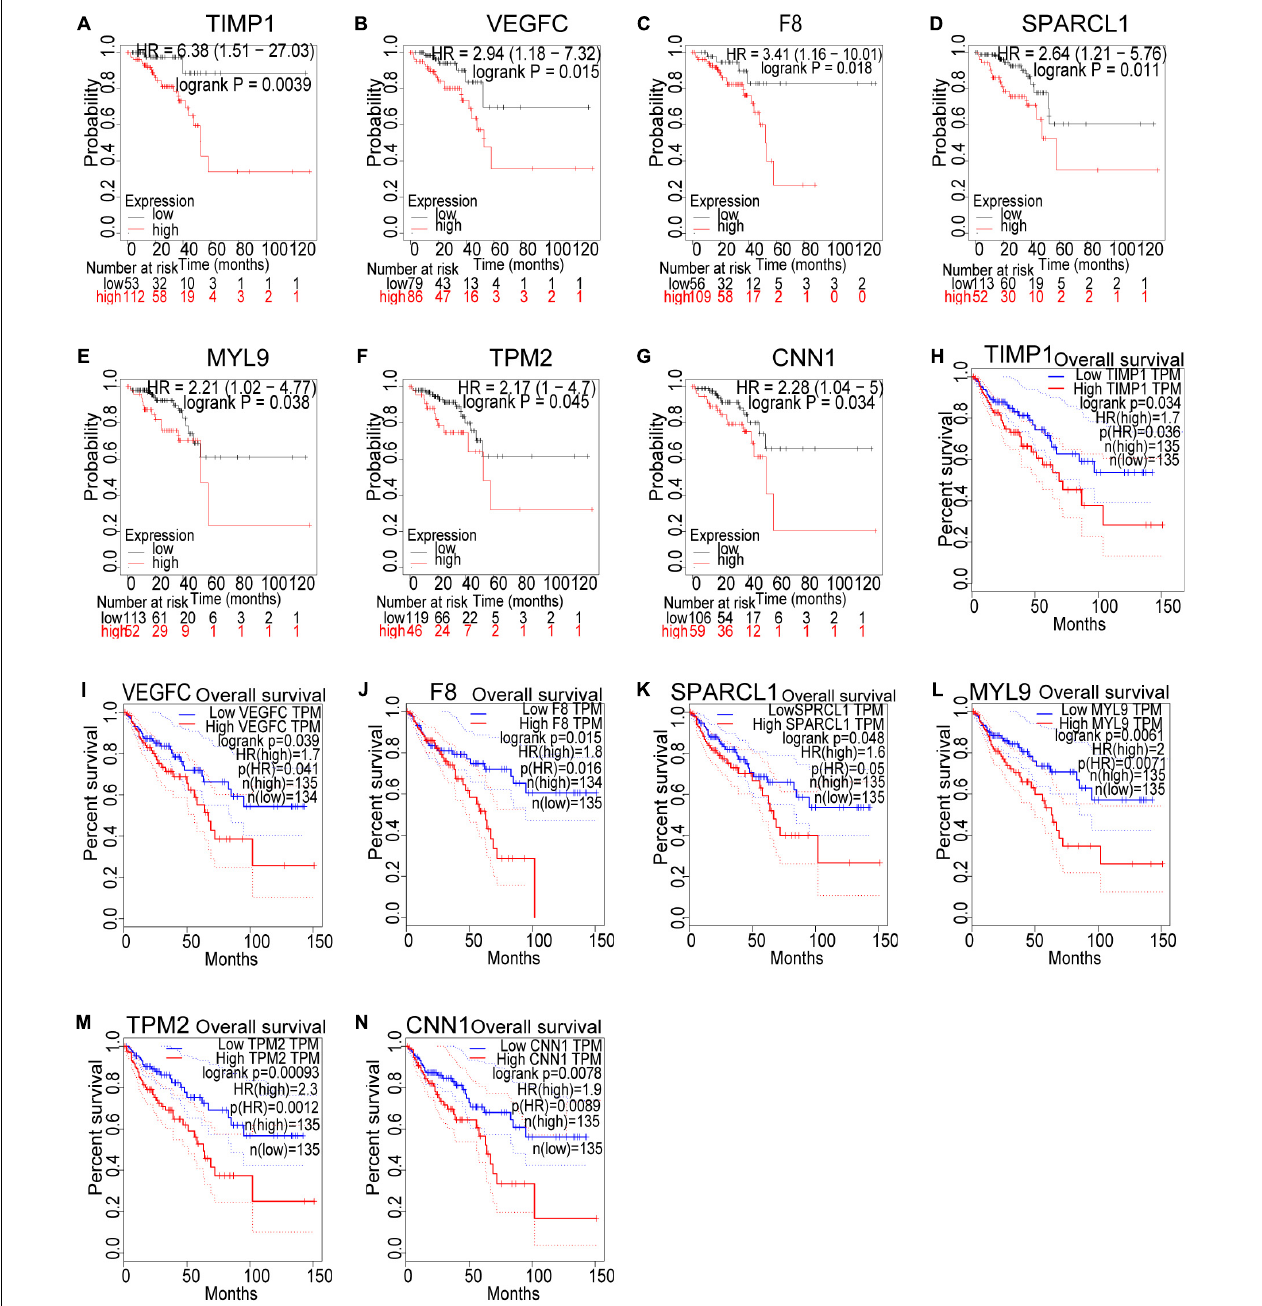
FIGURE 6 | Survival analysis of the seven hub gene candidates identified by the Kaplan–Meier plotter and GEPIA successively. (A–G) Overall survival of the seven candidate hub genes in CRC based on Kaplan–Meier plotter. (H–N) Overall survival of the seven candidate hub genes in CRC obtained from the GEPIA database. P < 0.05 was considered to indicate a statistically significant difference. TIMP1, metallopeptidase inhibitor 1; VEGFC, vascular endothelial growth factor C; F8, coagulation factor VIII; SPARCL1, SPARC Like 1; MYL9, myosin light chain 9; TPM2, tropomyosin 2; CNN1: calponin 1.